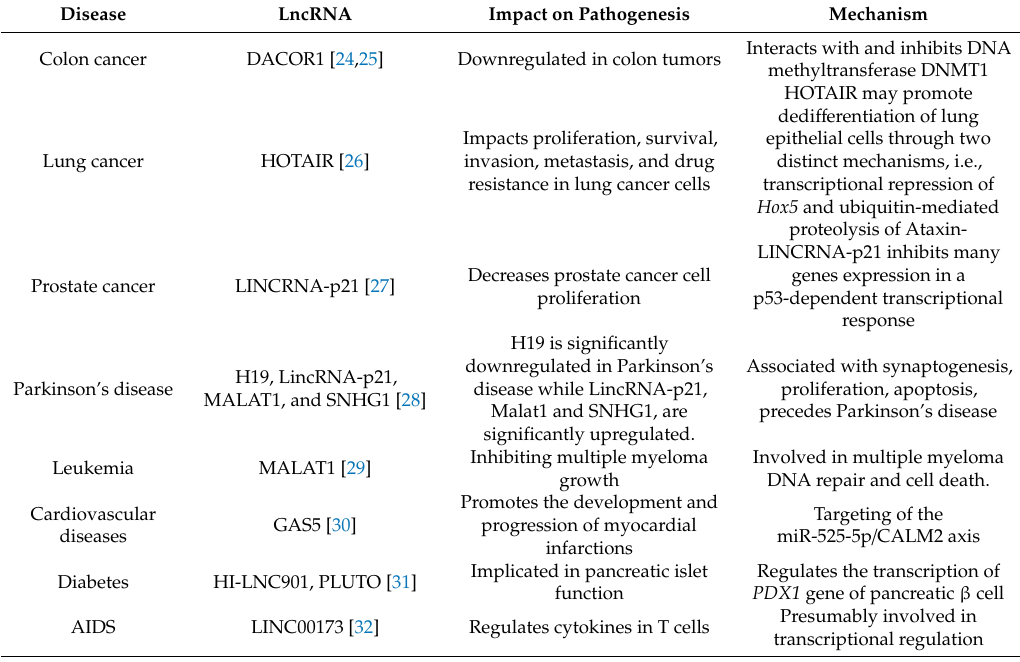
Table 1. Examples of pathogenesis related to lncRNA